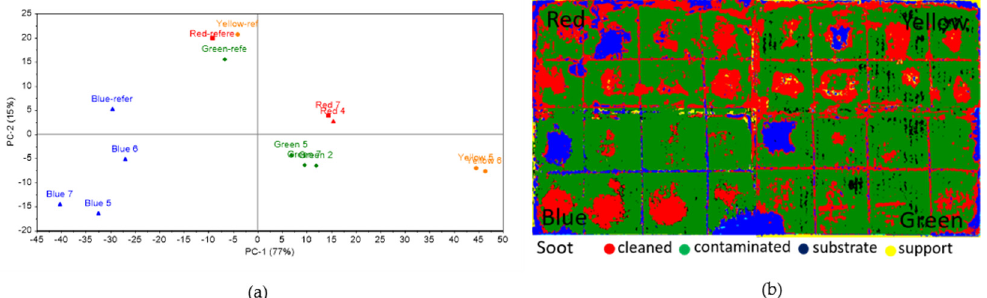
Figure 12. Colorimetric and hyperspectral evaluation of soot decomposition by Penicillium sp. BSL 3-2 esterases. ( a ) Score plot of the first 2 PCs, based on colorimetry data; ( b ) SAM images based on hyperspectral data. As soot cannot be identified via FTIR, the efficiency of the inoculation procedures could not be assessed with this method. The FTIR spectra (Supplementary Figure S9) only showed that some pigments appeared unaltered. No specific fungal traces have been detected for any of the examined areas.